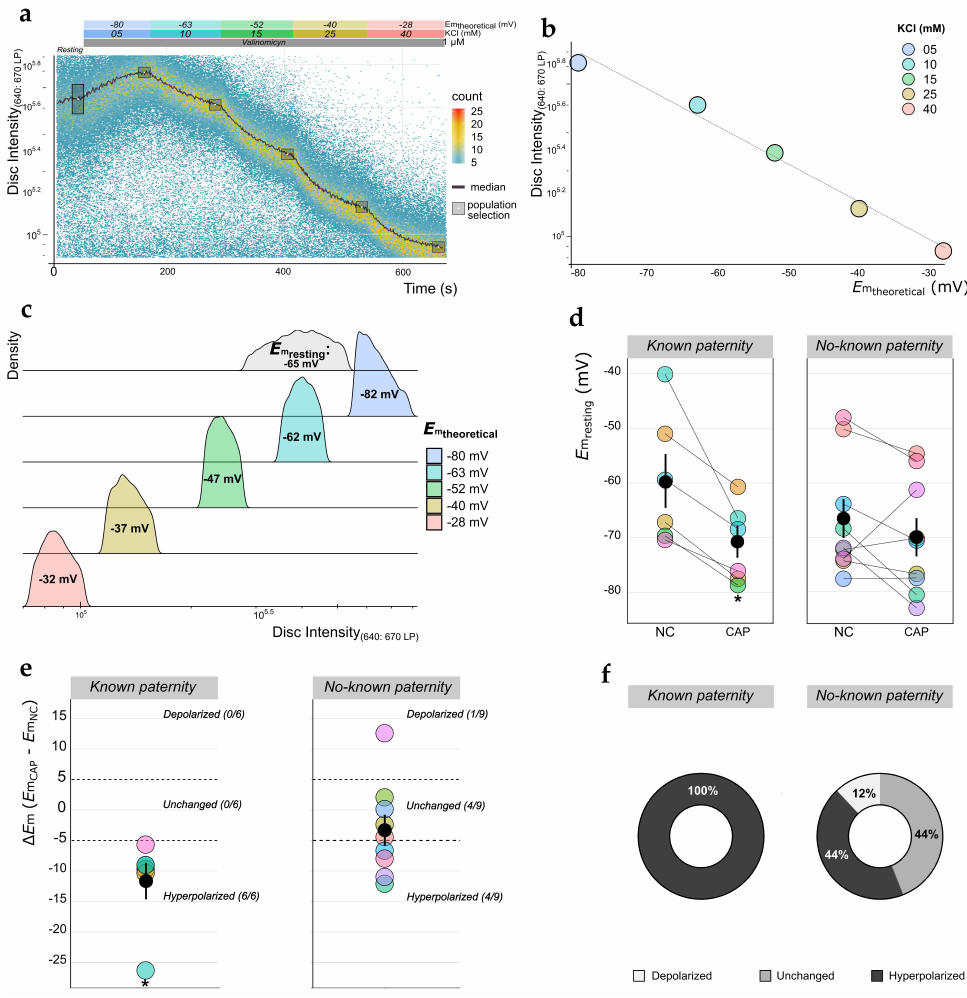
Figure 2. Measurement of membrane potential ( E m ) absolute values in human sperm. ( a ) Representative time-lapse flow cytometry (TLFC) 3,3 ′ dipropylthiadicarbocyanine iodide (DiSC 3 (5), abbreviated to Disc) fluorescence density plot of a sperm sample from a known paternity donor under capacitating (CAP) conditions. Colored boxes above the plot indicate the nature and duration of the employed stimuli. The dark solid line indicates the median fluorescence value. Gray boxes enclose the cell subpopulations selected for further calculations. ( b ) Median fluorescence values for the selected cell subpopulations indicated in ( a ) were plotted against the theoretical E m value (calculated using Nernst’s equation). The dashed line indicates the linear fit ( y = − 10,682.4x − 264,308; R 2 = 0.95; p = 0.003). ( c ) Density histograms of Disc fluorescence values from the subpopulations indicated in ( a ). For comparison, each colored histogram corresponds to each of the E m values (indicated inside histograms) estimated using the linear fit in ( a ); the interpolated resting E m value (gray histogram) of the resting sperm subpopulation was − 65 mV. ( d ) Plots of calculated E m values for individual sperm samples (shown color-coded) incubated under either non-capacitating (NC) or CAP conditions, from either known ( n = 6) or no-known ( n = 9) paternity donors. Black dots and solid lines indicate mean ± standard error of the mean (SEM), respectively; * p < 0.05 against NC according to a paired t -test. ( e ) Plots of capacitation-induced E m change ( Δ E m = E mCAP − E mNC ) for samples in ( d ). Samples with a Δ E m value greater, lower, or equal to ±5 mV were classified (dotted lines) as depolarized, hyperpolarized, or unchanged, respectively; numbers in parentheses indicate the number of samples in each category out of the total. Black dots and solid lines indicate mean ± SEM; * p < 0.05 according to a one-sample t -test comparison against a theoretical mean of Δ E m = 0. ( f ) Donut charts depicting the distribution of the results shown in ( e ).